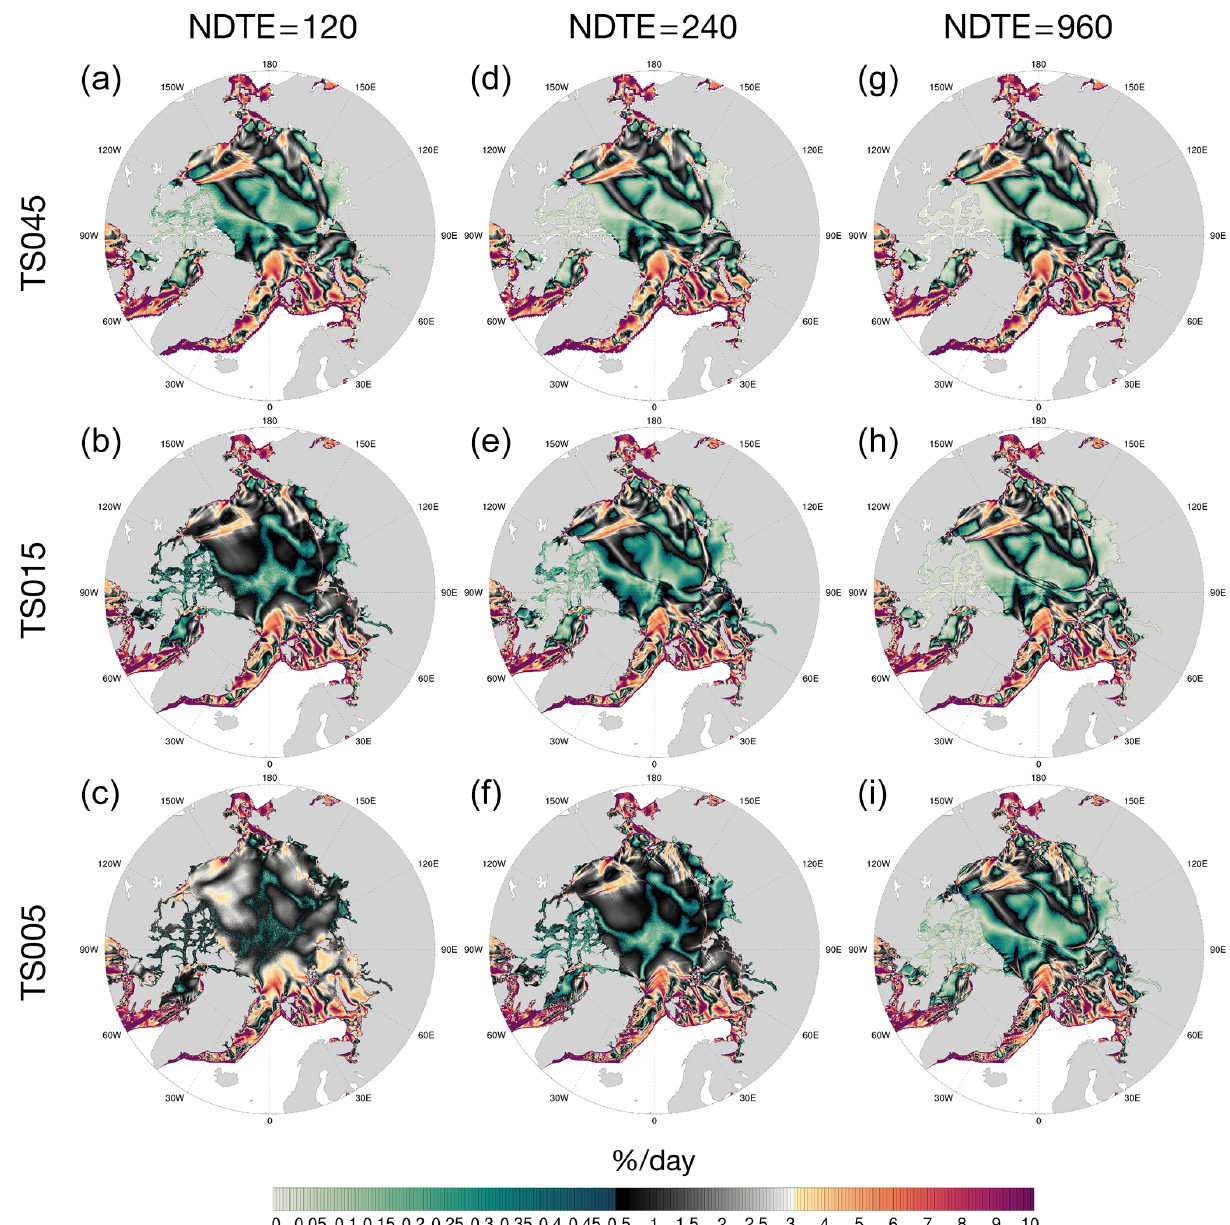
Figure 13. Total deformation rate on 20 December with NDTE = 120 (a–c) , 240 (d–f) , and 960 (g–i) . Each row represents a specific grid, including TS045 (a, d, g) , TS015 (b, e, h) , and TS005 (c, f, i) . Results with NDTE = 960 are reproduced from Fig. 7. The color map is adjusted from Fig. 7 for increased resolution under 1%d − 1